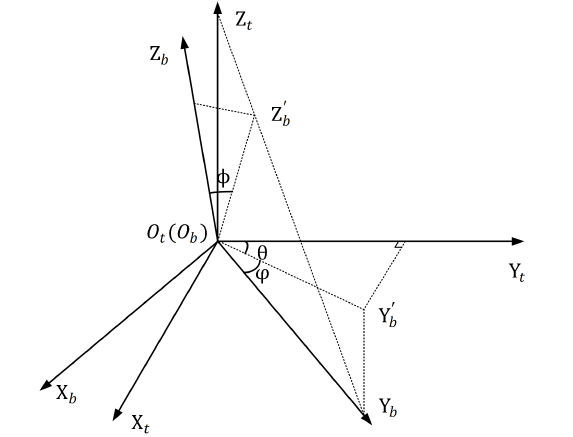
Figure 2. Graphical diagram for the altitude